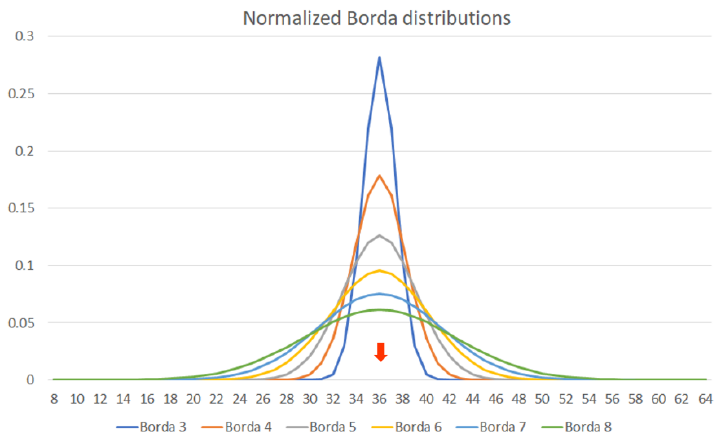
Figure A2. Fractal behavior pattern of row sum totals in Borda distribution for n = 4. ( a ) Reduced table of frequencies for matrix dimension 4 × 4, ( b ) Fractal example for matrix dimension 4 × 4 case where magic number is 10, ( c ) Fractal pattern for matrix dimension 4 × 4 case and ( d ) Example of a Hankel matrix.